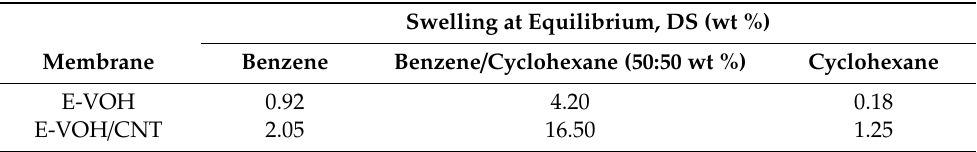
Table 2. Comparison of the swelling degrees between E-VAL and E-VAL / CNT membranes in benzene / cyclohexane mixtures with di ff erent compositions.